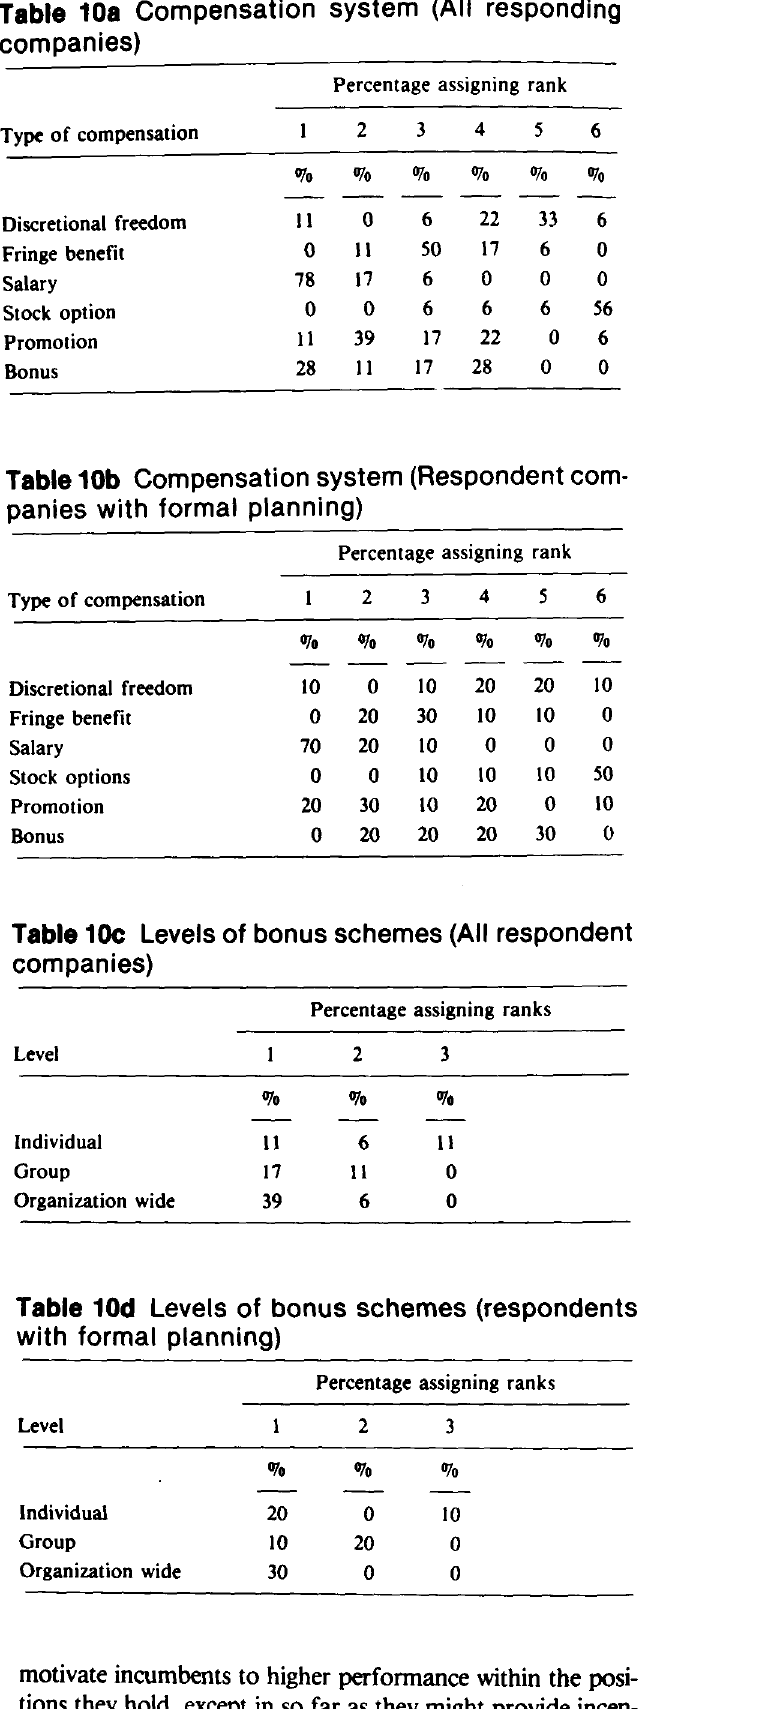
Table 10a Compensation system (All responding